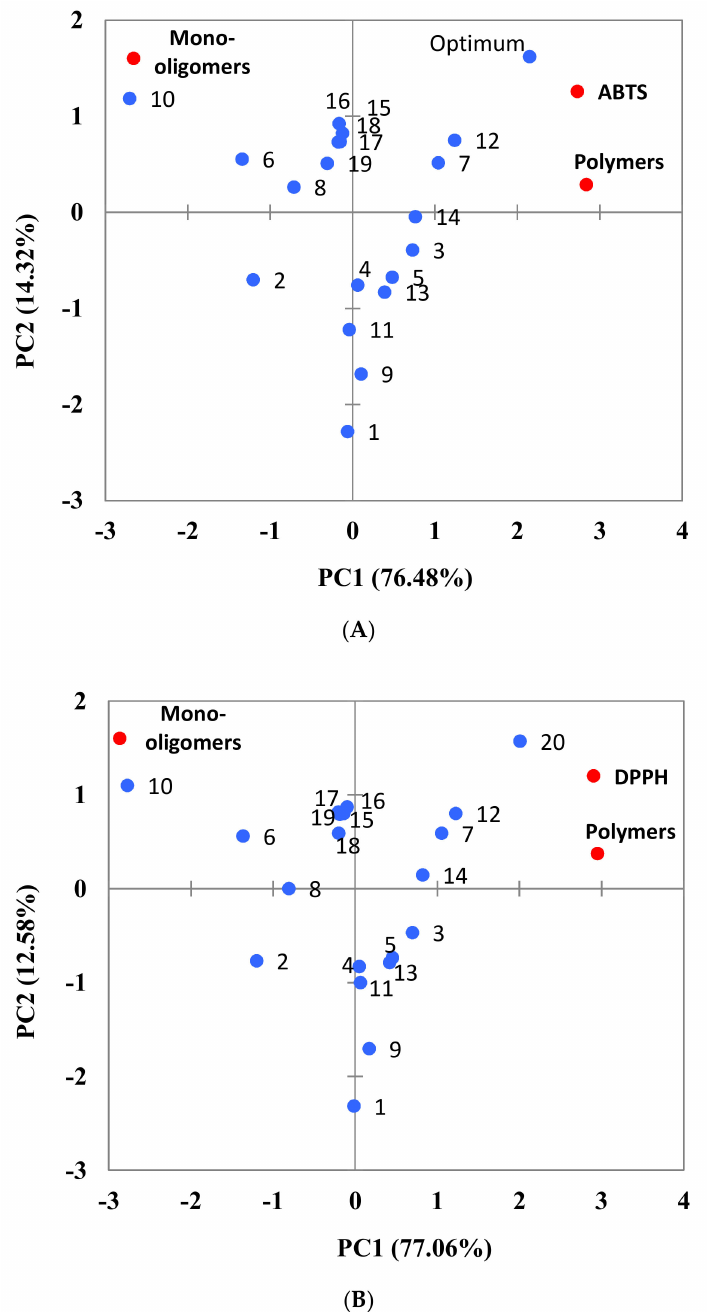
Figure 7. Principal components analysis (PCA) of response variables. Projections of the variables and samples (Biplot) for ABTS ( A ) and DPPH values ( B